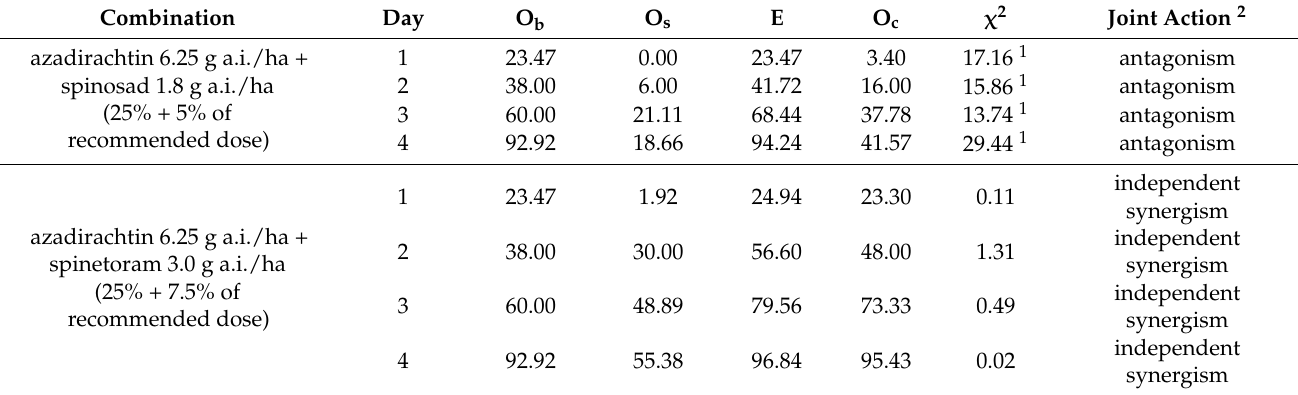
Table 6. Joint action of insecticides on Colorado potato beetle larval